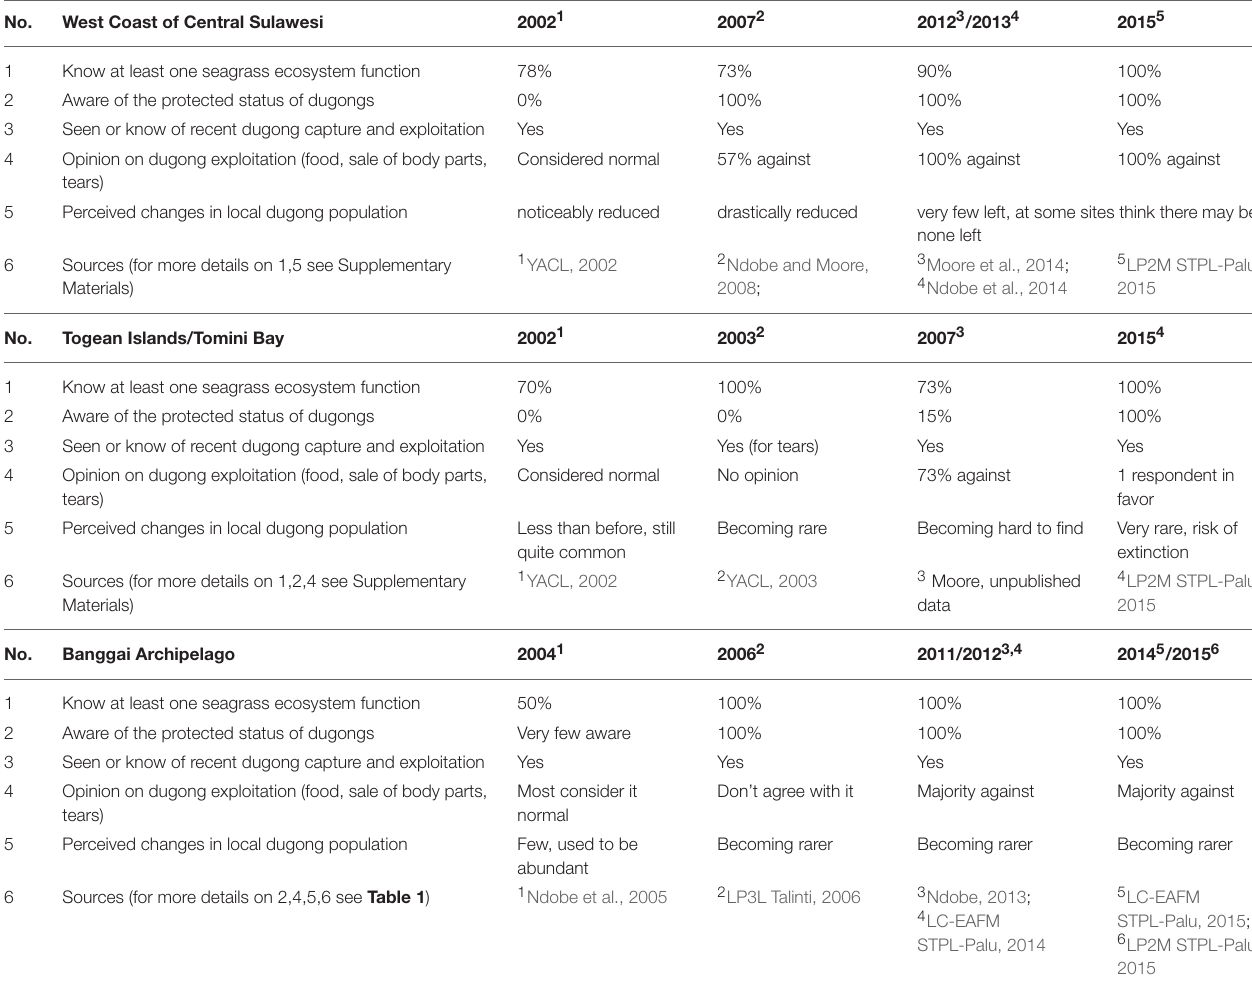
TABLE 3 | Selected data from knowledge, attitude, and perception (KAP) studies by geographical area and year or time period.